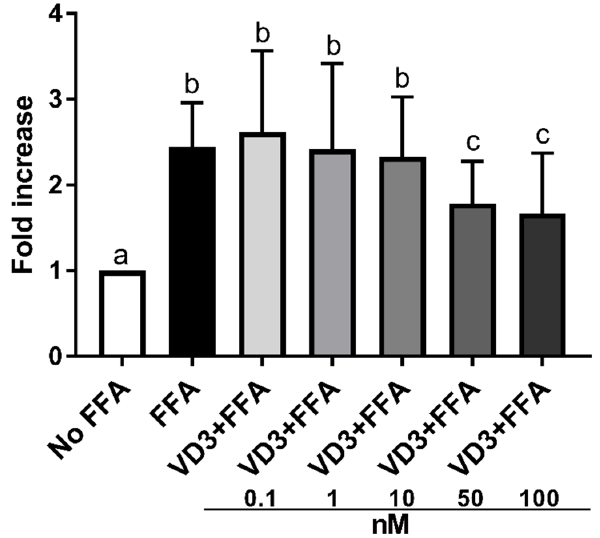
Figure 3. Effect of different concentrations (0.1–100 nM) of VD3 on cell lipid accumulation. Data are reported as a fold increase and mean ± standard deviation. a,b,c Bar graphs with different letters are significantly different ( p ≤ 0.01). No FFA: no free fatty acids (control); FFA: free fatty acids (500 μ M); VD3: calcitriol + free fatty acids (500 μ M).